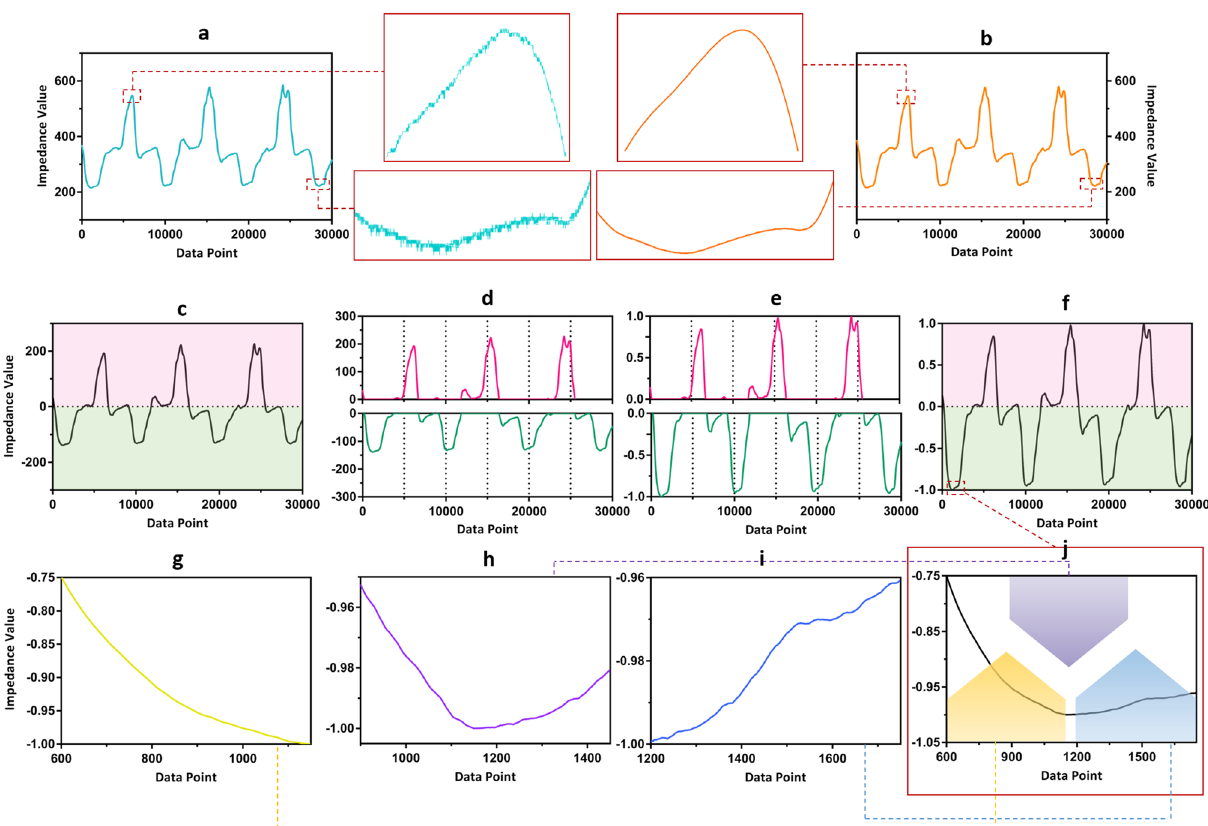
Figure 5. Collecting raw data, filtering, normalizing. ( a ) Raw data ( b ) Filtered data ( c ) Data shifted down by baseline value ( d ) Separating points above and below baseline value ( e ) Normalizing separately points above and below baseline value ( f ) Normalized value ( g ) Obtained data segment 1 ( h ) Obtained data segment 2 ( i ) Obtained data segment 3 ( j ) Zoomed in normalized